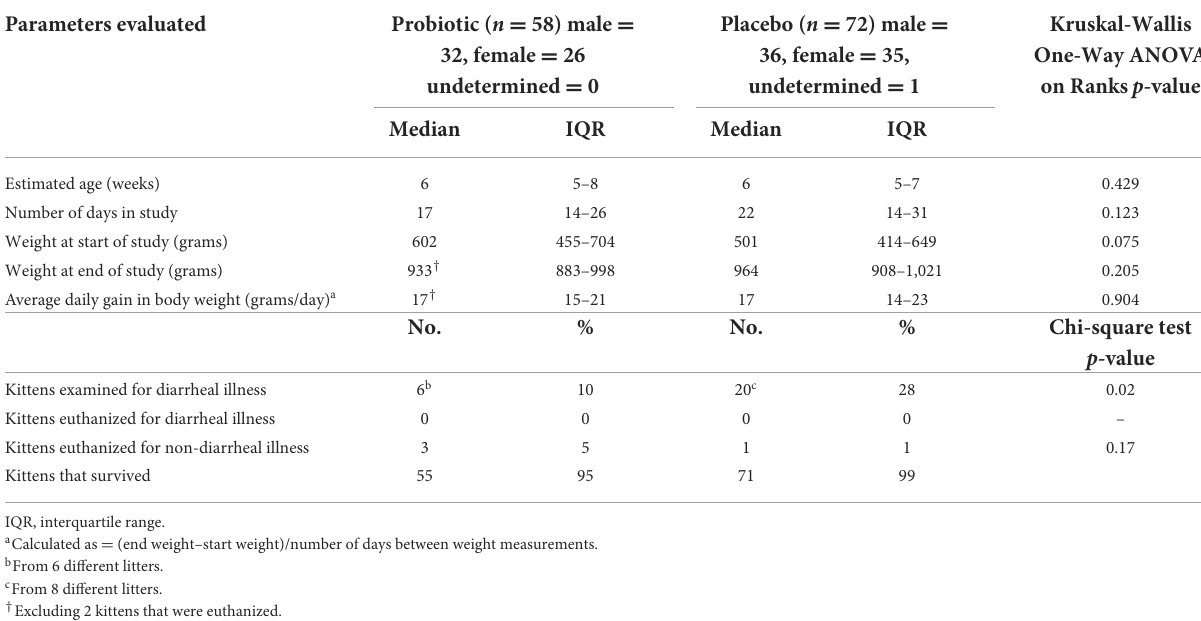
TABLE 1 Population description of 130 kittens treated with probiotic or placebo.